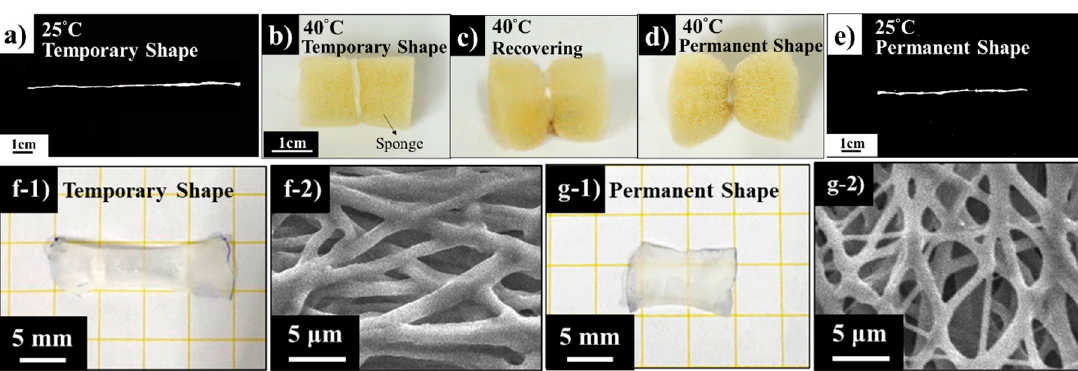
Figure 10. Visual demonstration of the nanofibres’ shape recovery performance: ( a,b ) temporary shape; ( c ) during recovery; ( d ) recovered to the permanent shape; ( e ) permanent shape; ( f-1 ) temporary shape macroscopic view of nanofibre mesh; ( f-2 ) temporary shape microscopic view of nanofibre mesh; ( g-1 ) permanent shape macroscopic view of nanofibre mesh; ( g-2 ) permanent shape microscopic view of nanofibre mesh.